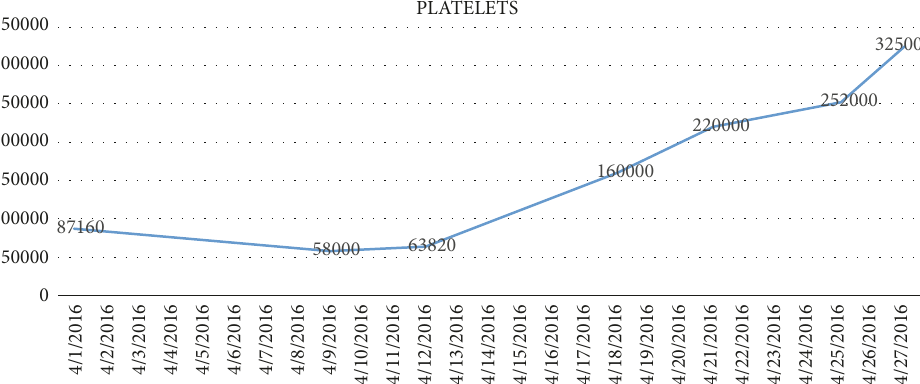
Figure 5: This graphic shows the platelet count decrease at the beginning of the disease; that is the reason of suspect Thrombotic thrombocytopenic purpurea; we can see the ascending curve after day 19 with the start of Eculizumab therapy.